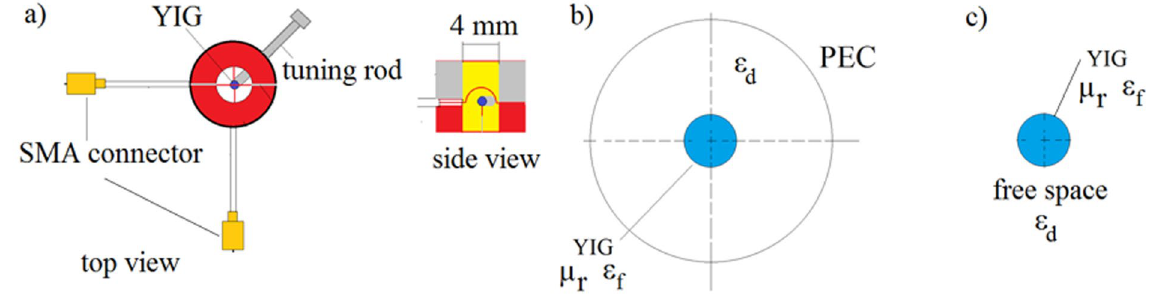
Figure 2. Setup. ( a ) Experimental setup. Model of a gyromagnetic sphere ( b ) in the conducting enclosure and ( c ) in the free space used in theoretical